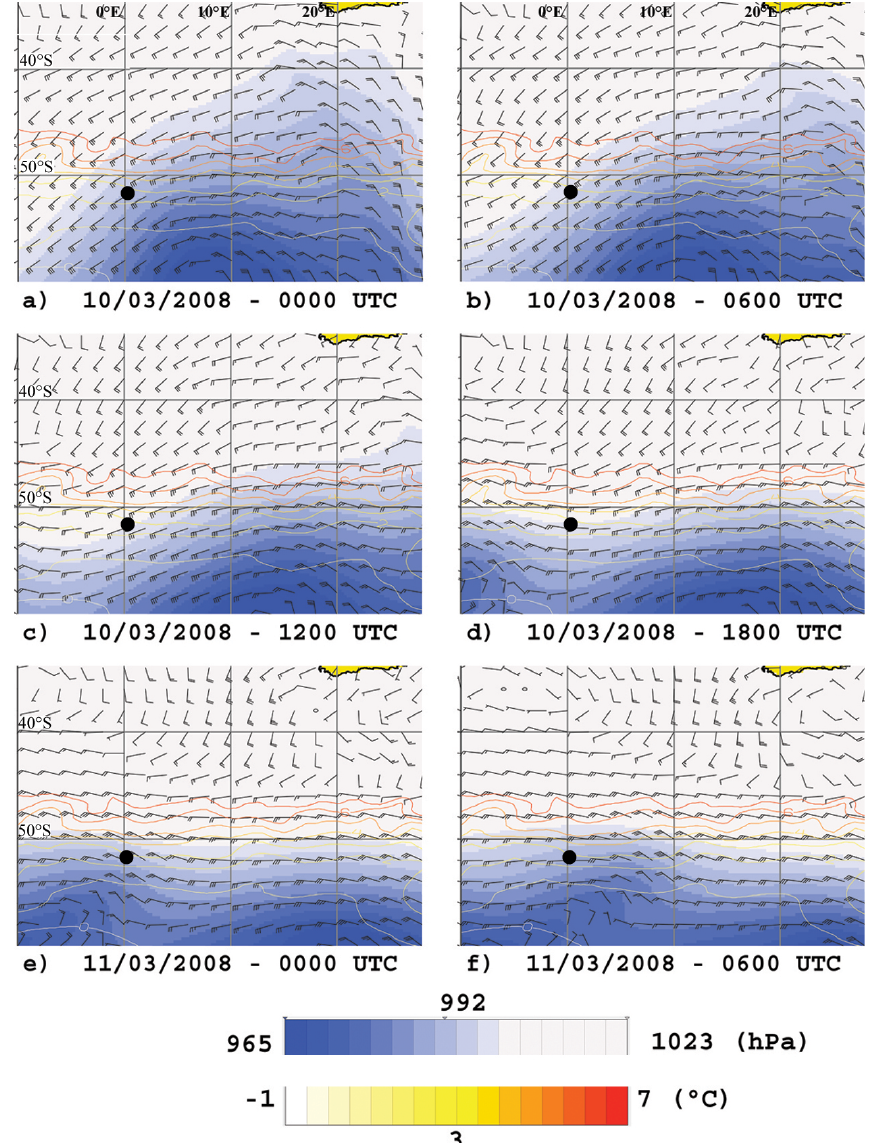
Fig. 11. Synoptic situation during the 10 and 11 March (from ECMWF ERA interim reanalysis). Colored background is the medium sea level pressure, isolines are SST (contour interval is 1 ◦ C). Wind barbs (in knots) are overlaid. Black points indicate the ship location (42.5 ◦ S/9 ◦